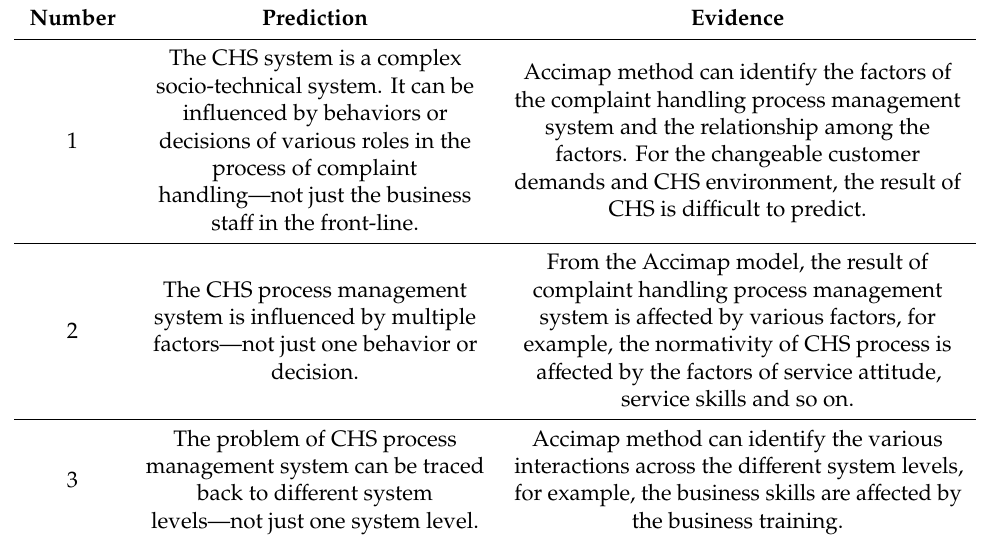
Figure 15. Complaint Handling Process Management Accimap Model. Table 3. The results of the testing of Rasmussen’s